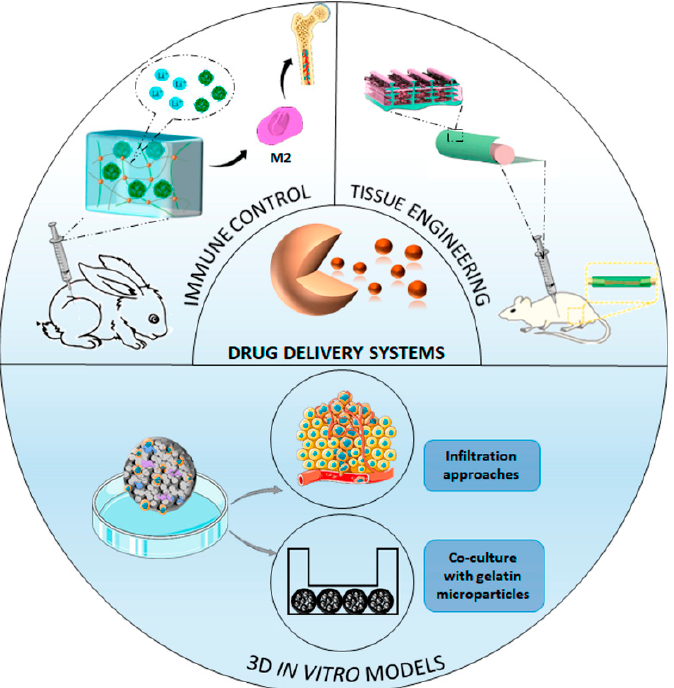
Figure 6. Representative graphic of gelatin-based drug delivery systems. Adapted with permission from Hu Y et al. [77]. ASC Nano. Copyright 2022, American Chemical Society; reprinted from Chemical Engineering Journal, 435, Li D et al. [84]. Osteoimmunomodulatory injectable Lithium-Heparin hydrogel with Microspheres/TGF- β 1 delivery promotes M2 macrophage polarization and osteogenesis for guided bone regeneration, 134991, copyright (2022), with permission from